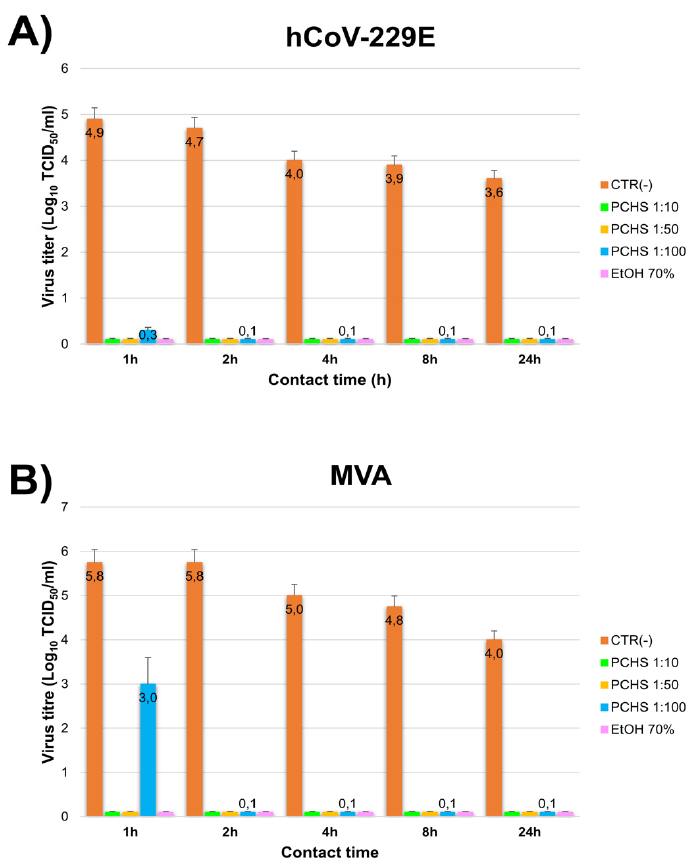
Figure 2. PCHS activity in surface decontamination tests. Assays were performed by applying the indicated PCHS dilutions (1:10, 1:50, and 1:100) to surfaces previously contaminated with the indicated viruses. Samples were collected 1, 2, 4, 8, and 24 h, and the residual virus titre was evaluated by Spearman Karber method. 70% EtOH was used as control; results are expressed as Log 10 TCID 50 / mL , and represent the mean ± SD values of duplicate samples from three independent assays. ( A ) hCoV-229E results. ( B ) MVA results.